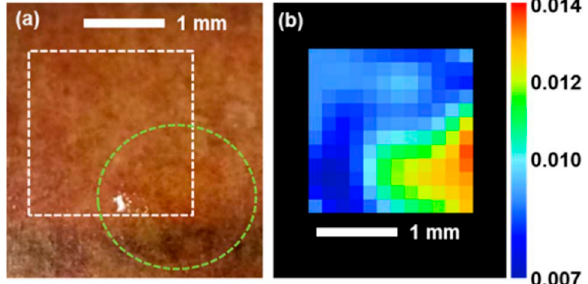
Figure 5. ( a ) Photograph of the apple peel with methomyl stain (green dashed circle). The white dashed line is the positioned nano-slot-antenna region. ( b ) Normalized THz reflection image taken through the nano-slot-antenna attached to the apple peel sample with a residual methomyl stain. (Reprinted/Adapted) with permission from [84] © 2016, IEEE.